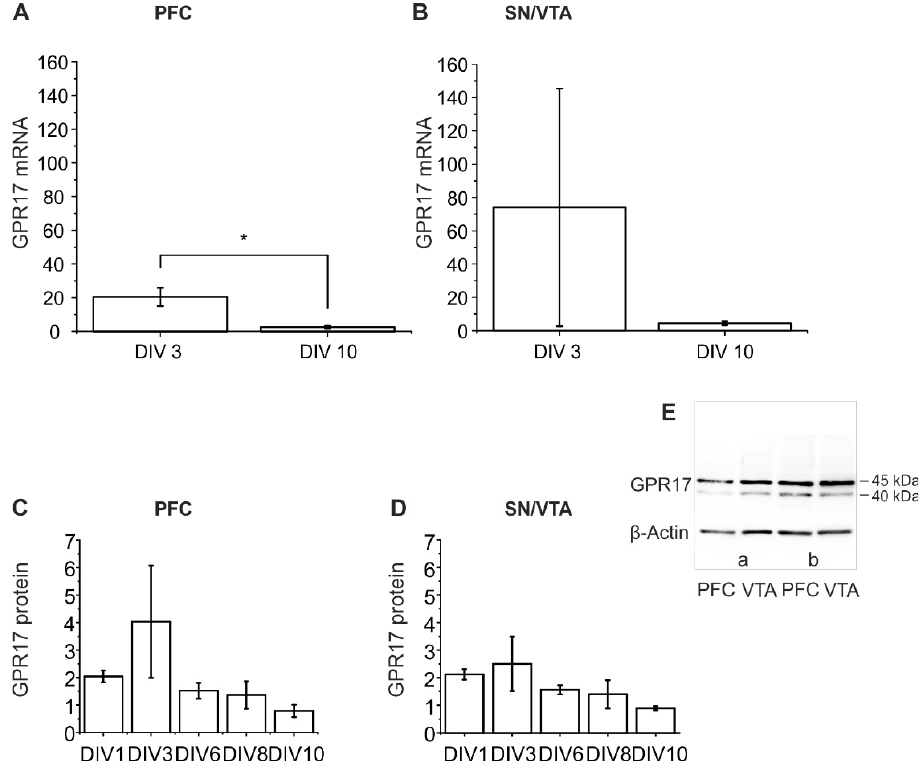
Figure 4. Results of RT-qPCR and Western blot of GPR17 in the ex vivo co-cultures. Expression of mRNA of the GPR17 is shown as ∆ CP in the PFC ( A ) and SN/VTA ( B ) after DIV 3 and DIV 10. Statistical analysis was performed in comparison to vehicle control with ANOVA on ranks followed by Tukey‘s test. Data are shown as bar charts. The number of animals was n = 3, * p < 0.05. Protein expression of GPR17 is shown on DIV 1, 3, 6, 8 and 10 in PFC ( C ) and SN/VTA ( D ), data are shown as bar charts. The number of animals being used was n ≥ 3. For statistical analysis one-way ANOVA (PFC) and Kruskal–Wallis (SN/VTA) was used. ( E ) Representative examples of Western blot images of samples obtained (DIV 10; (a) ctrl (Ethanol); (b) MTK 10 µM).